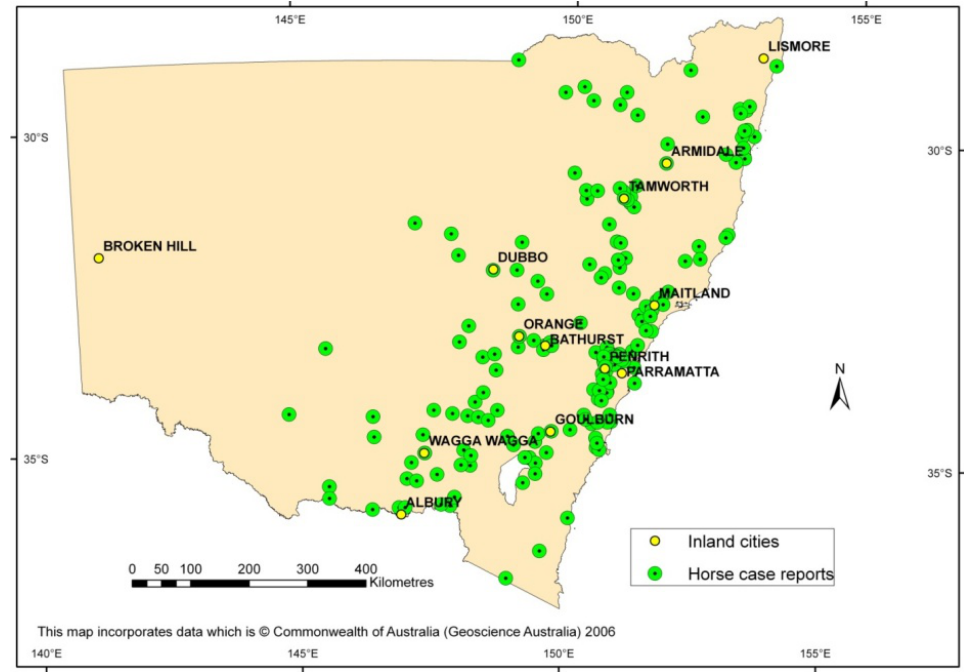
Figure 3. Distribution of horse cases during the 2011 outbreak. Adapted from